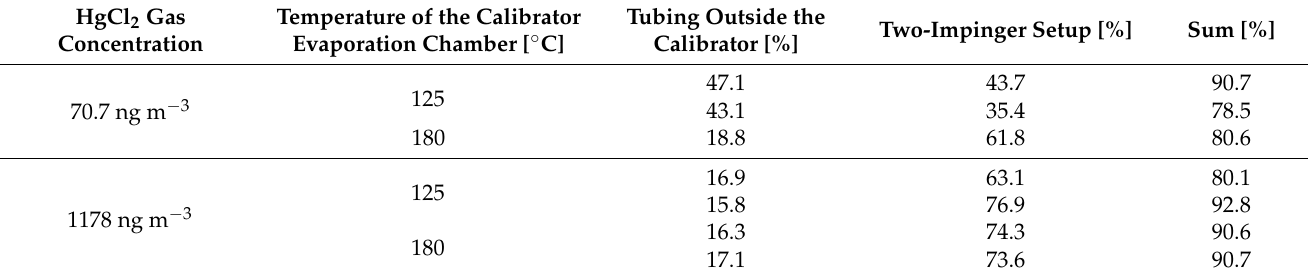
Table 3. The HgCl 2 adsorption of the tubing outside the calibrator in dependence on HgCl 2 gas concentration and the temperature of the calibrator evaporation chamber. HgCl 2